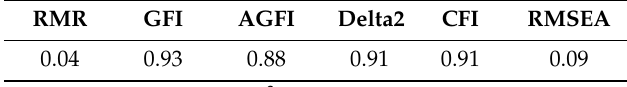
Table A1. Fit indices for the scale of positive active aging.